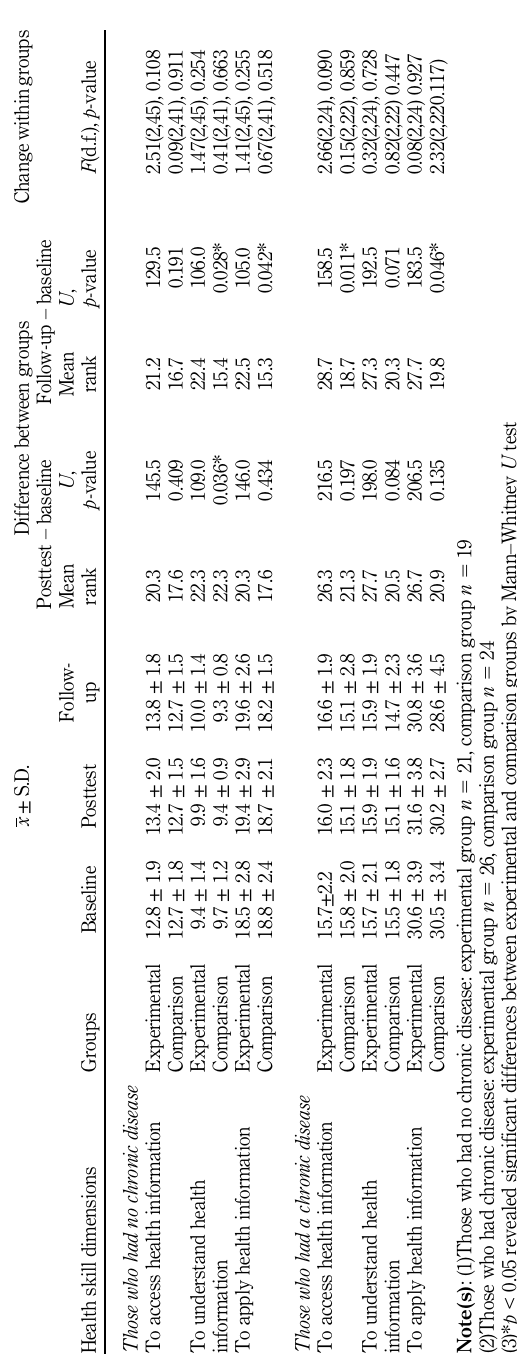
Table 3. Health skill improvement of HRP